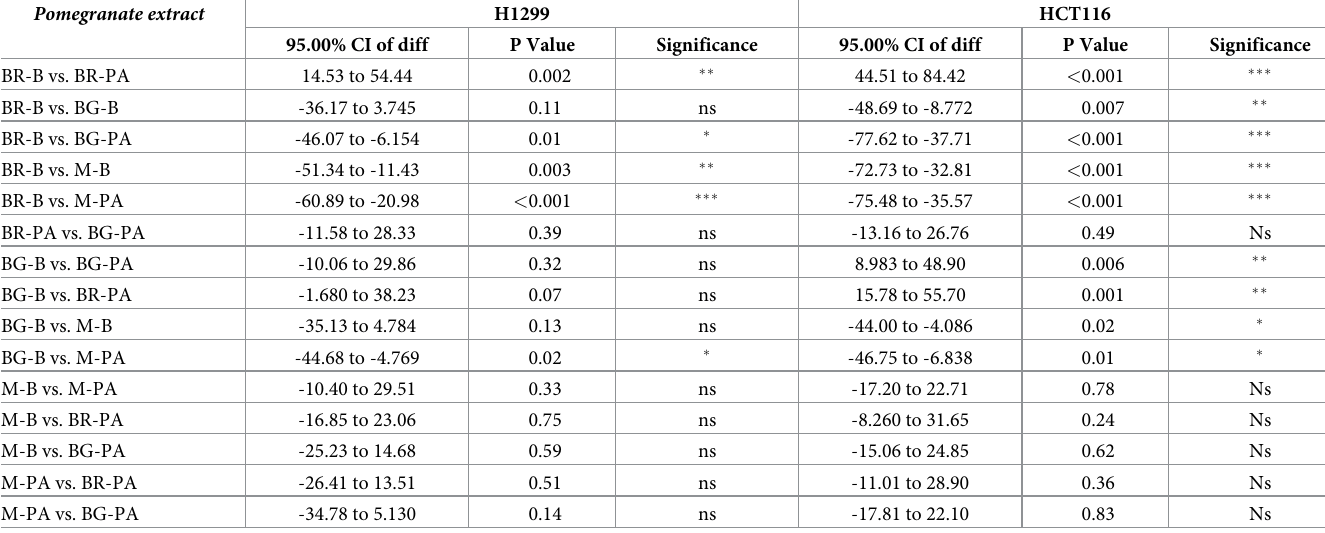
Table 2. Statistical comparisons of antiproliferative activity of pomegranate immature and mature fruits treatments in cancer cells H1299 and HCT116 a . Pomegranate extract